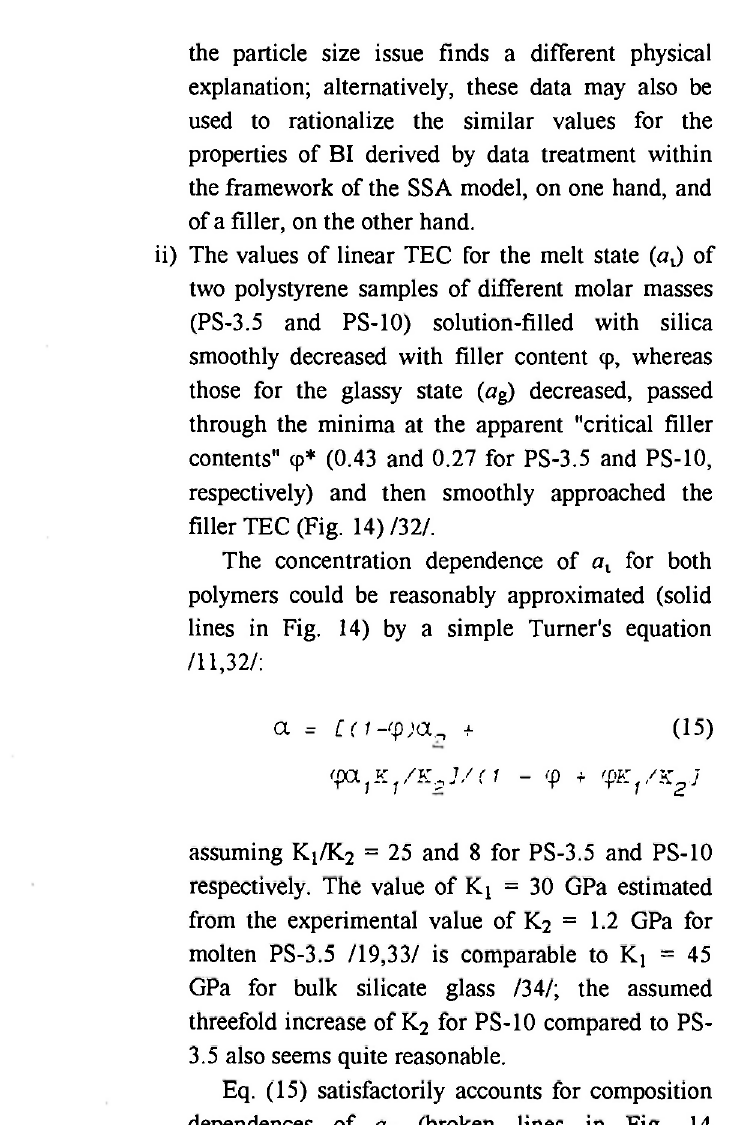
Fig. 14: Composition dependence of linear TEC for silica-filled polystyrenes PS-3.5 (a) and PS- 10 (b) in the melt (open points) and glassy (filled points)